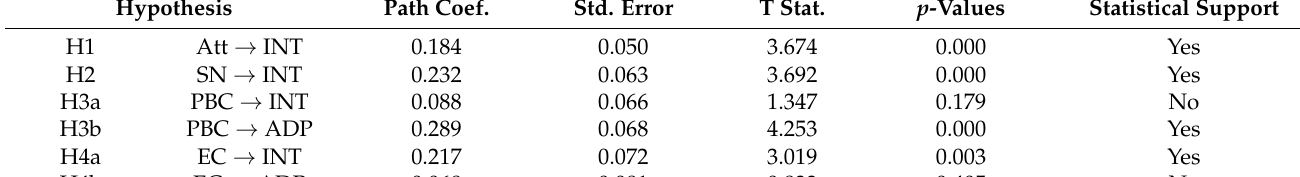
Table 5. Result of the structural model.